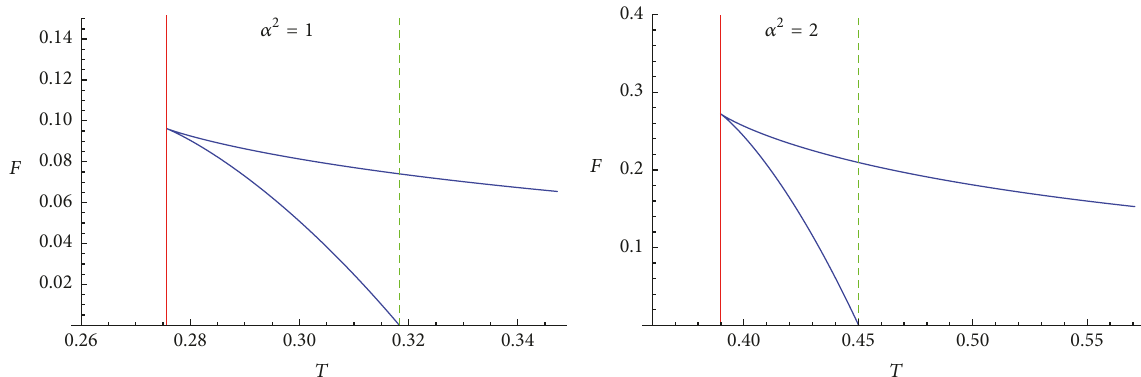
Figure 2: The Helmholtz free energy of the black hole as a function of temperature 𝑇 . The dashed green line stands for the Hawking-Page transition temperature, while the solid red line represents the minimal